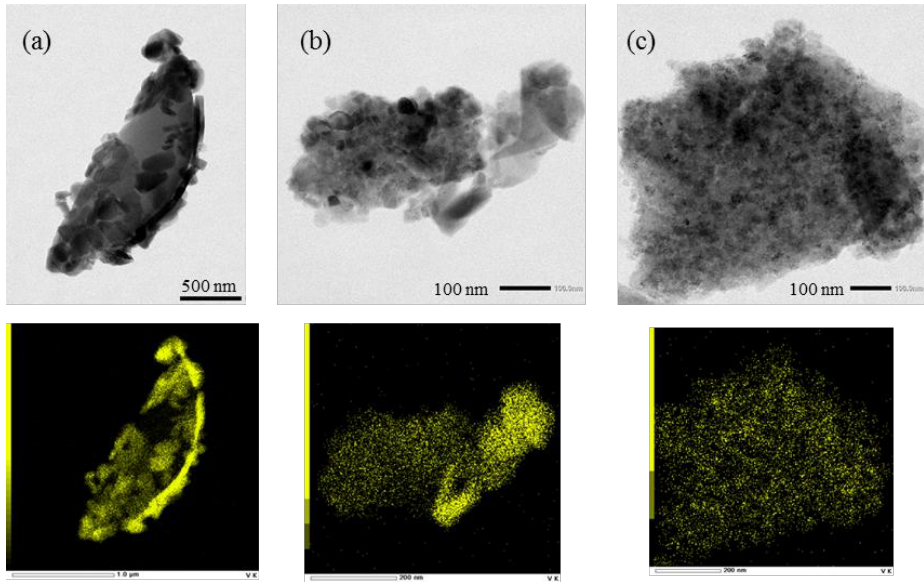
Figure 5. Scanning transmission electron microscope (STEM) images and Energy dispersive X-ray spectroscopy (EDS) mapping results of vanadia for fresh ( a ) 1.5V/Si ( b ) 1.5V/Ti ( c ) 1.5V/SiTi(30).